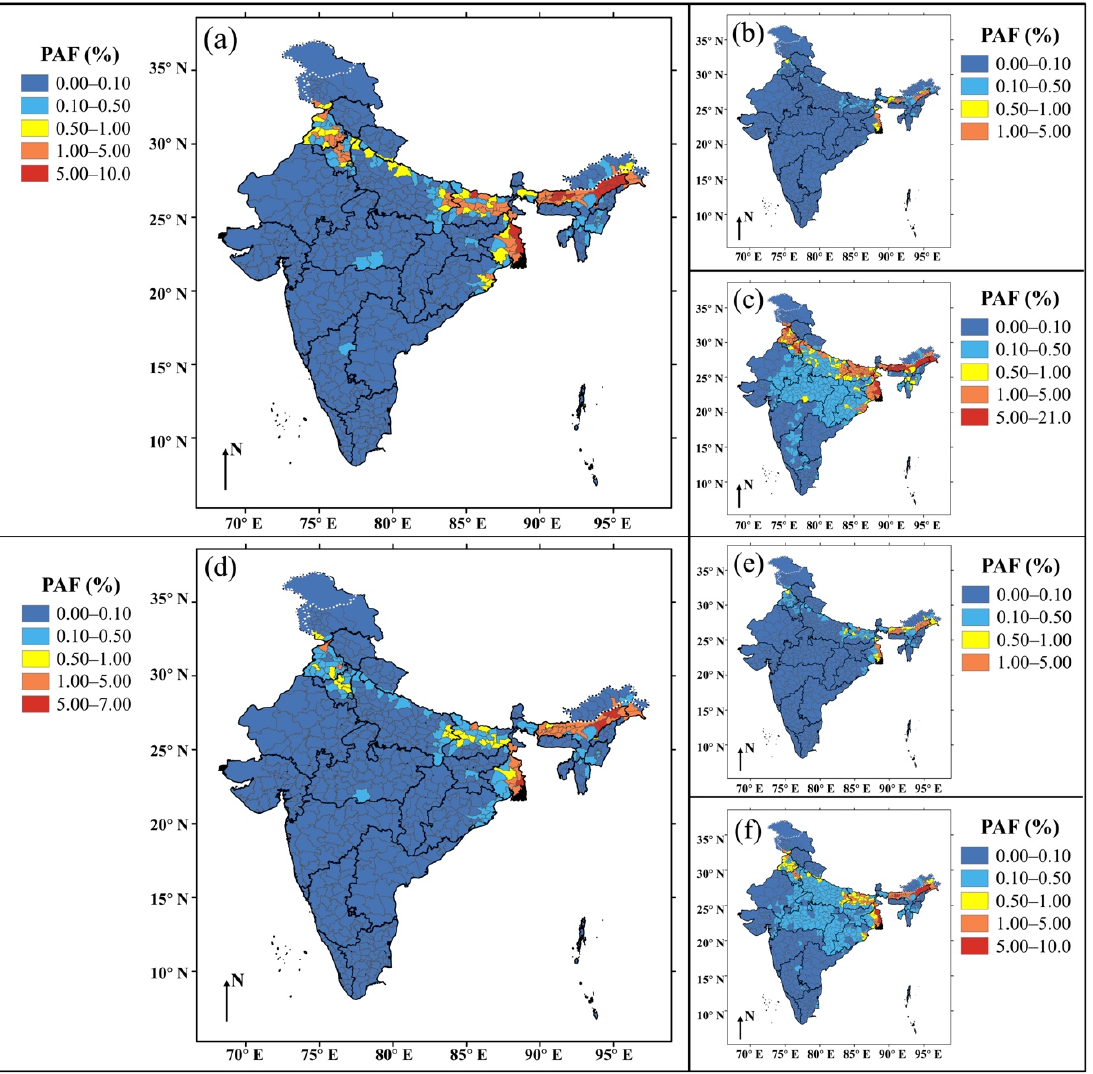
Figure 5. District-level maps of India showing ( a , d ) population-attributable fraction (PAF) of high groundwater arsenic- attributable CVD mortality with error boundaries (lower ( b , e ) and upper ( c , f ) limits) based on exposure model 1 (see text). PAF estimations were based on both linear ( a – c ) and non-linear ( d – f ) dose–response relationships between cardiovascular disease mortality and arsenic concentration in drinking water.